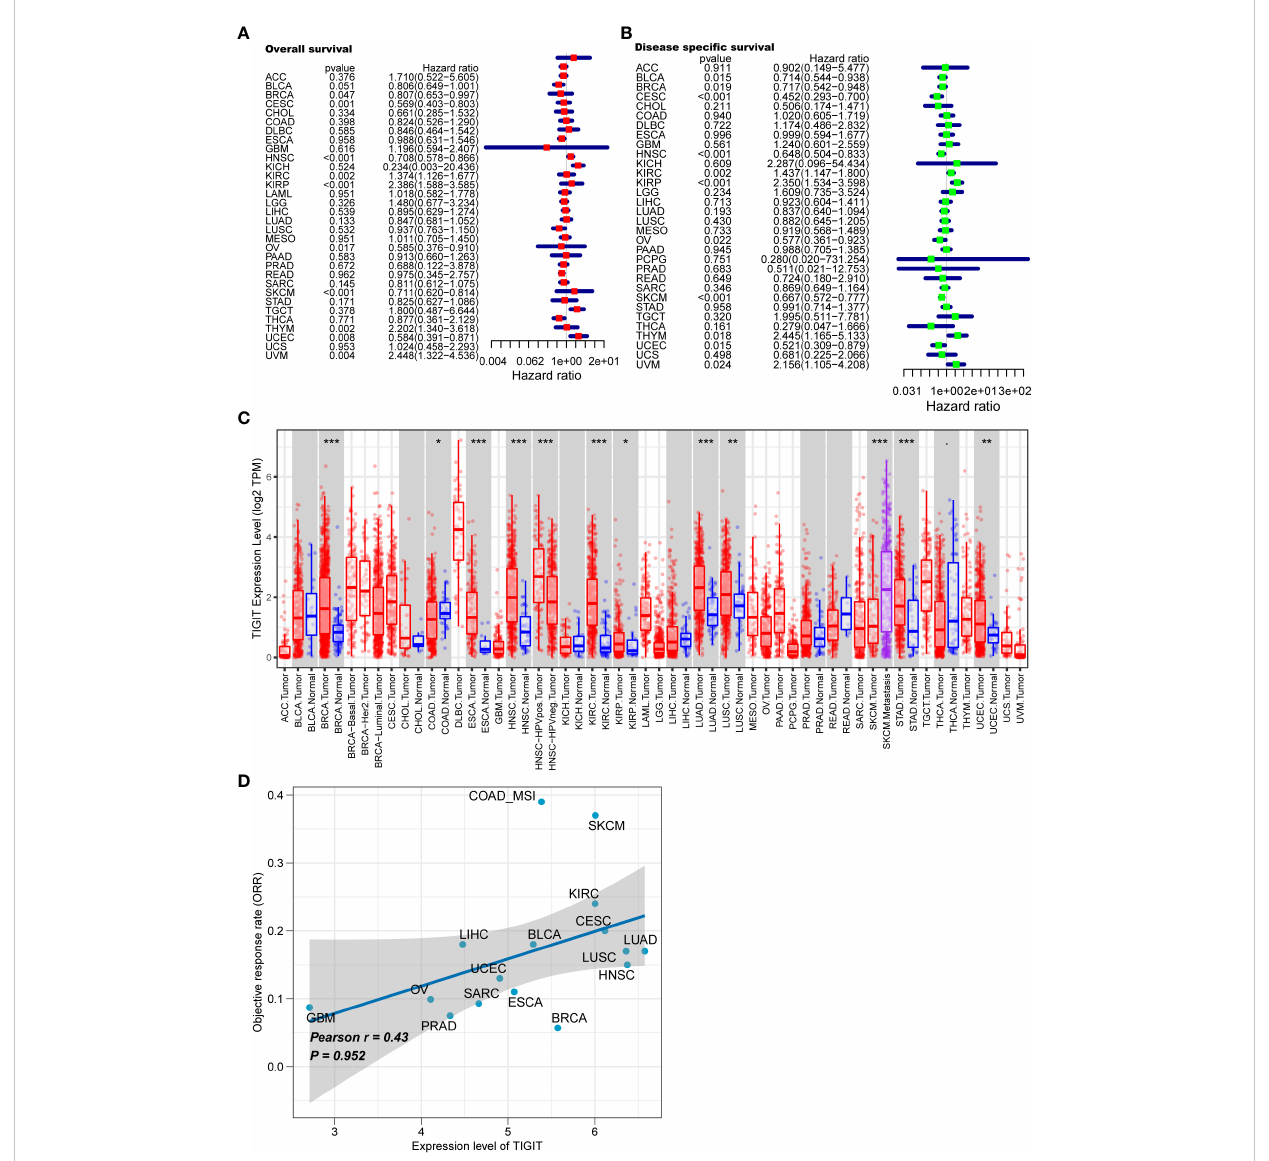
FIGURE 2 Analysis of TIGIT in pan-cancer. (A) Univariate Cox regression showed the OS of TIGIT in pan-cancer. (B) Univariate Cox regression showed the disease speci fi c survival of TIGIT in pan-cancer. (C) Differential expression status of TIGIT in pan-cancer. (D) The potiential association between the expression level of TIGIT and objective response rate in various cancers. *: p<0.05, **: p<0.01, ***: